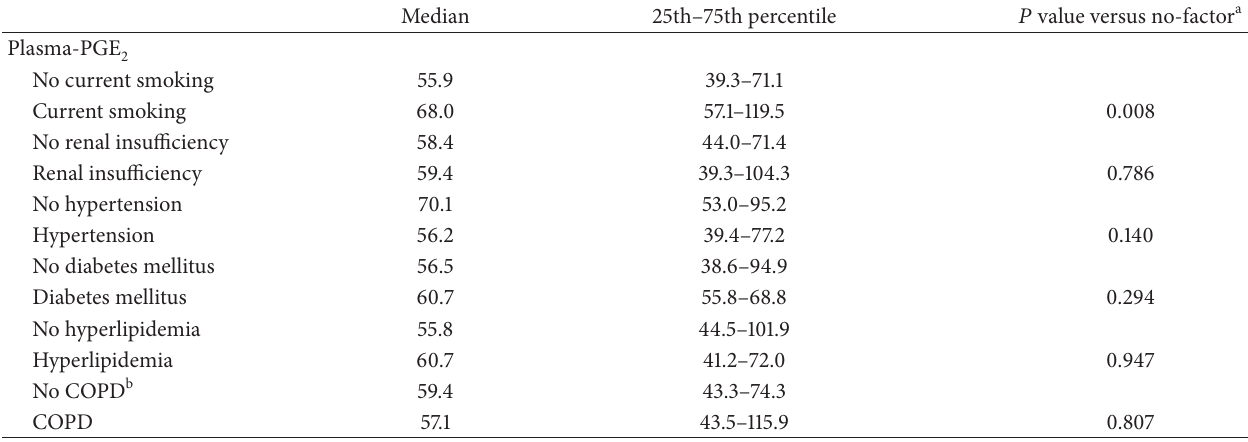
Table 4: Plasma levels of PGE in the AAA samples stratified by cardiovascular risk factors. The number of patients in every group is indicated 2 are expressed as in Table 1. Plasma levels of PGE 2